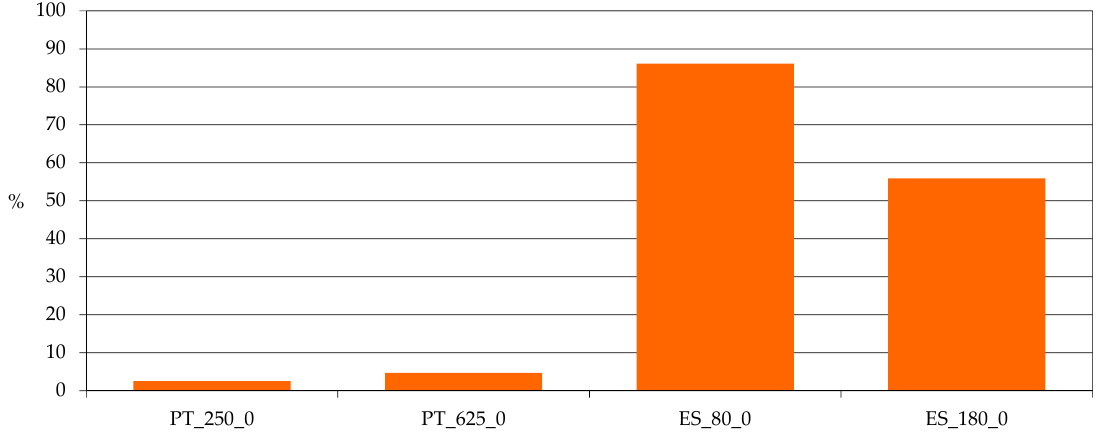
Figure 8. Share of purchased feed. Source: model results.